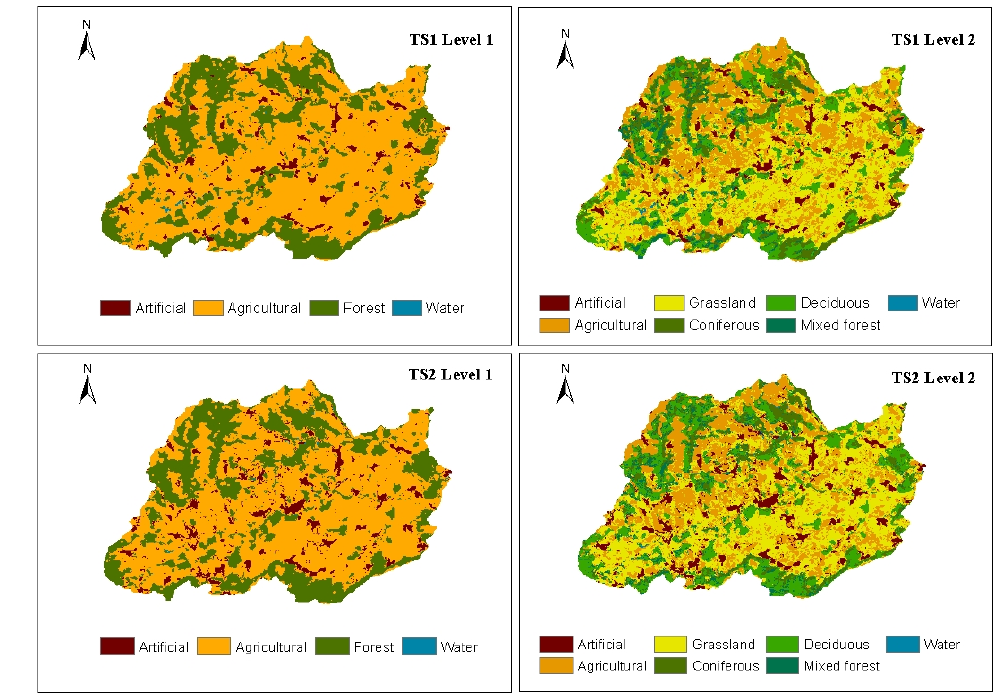
Figure 5. Level 1 and Level 2 land cover maps classified by the k-NN algorithm with time series of thermal images from Landsat 4/5 TM for TS1 and